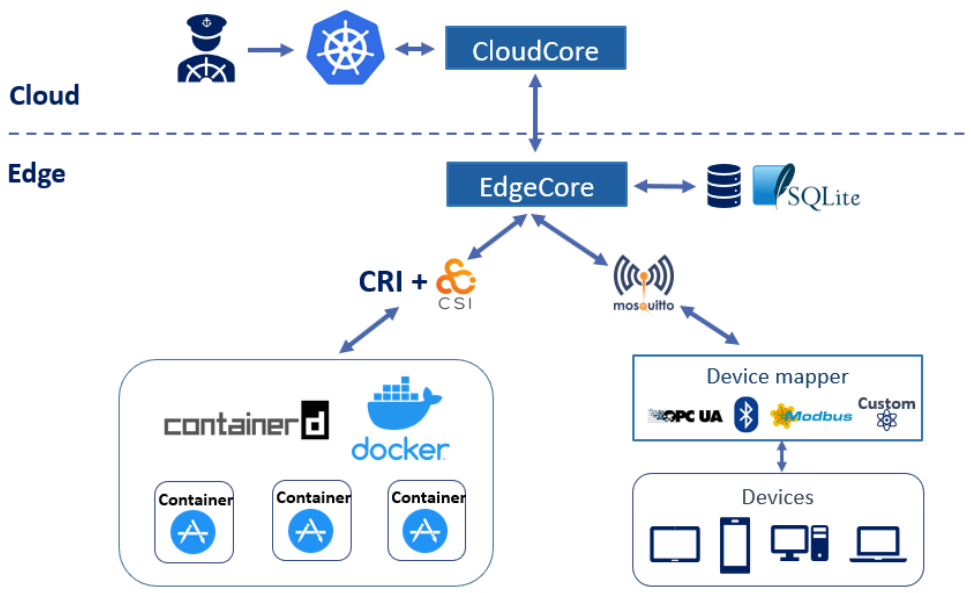
Figure 1. KubeEdge architecture.